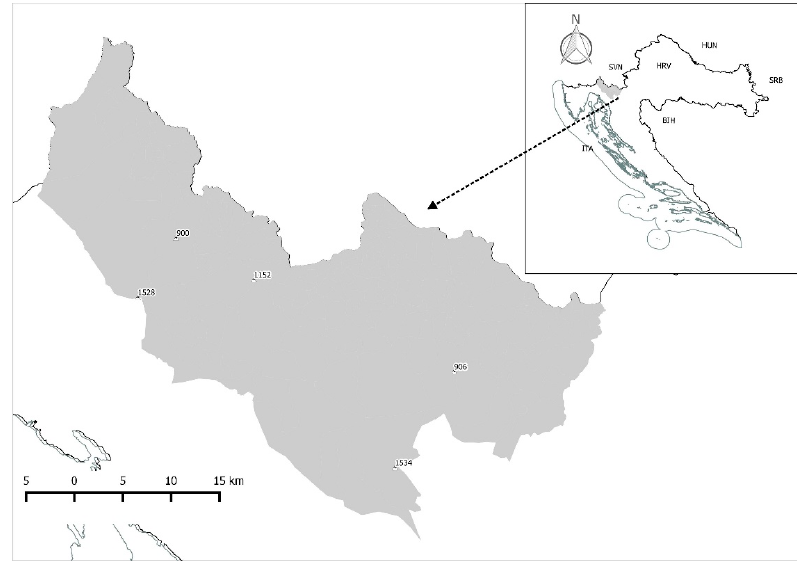
Figure 1. Study area map (Gorski Kotar, Croatia).